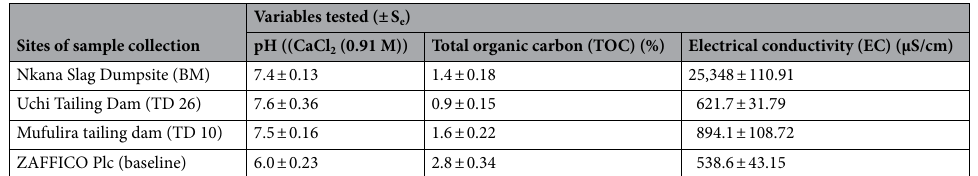
Table 2. Mean ± S e of pH, electrical conductivity and total carbon content of the mine soil samples collected from BM, TD 26 and TD 10.